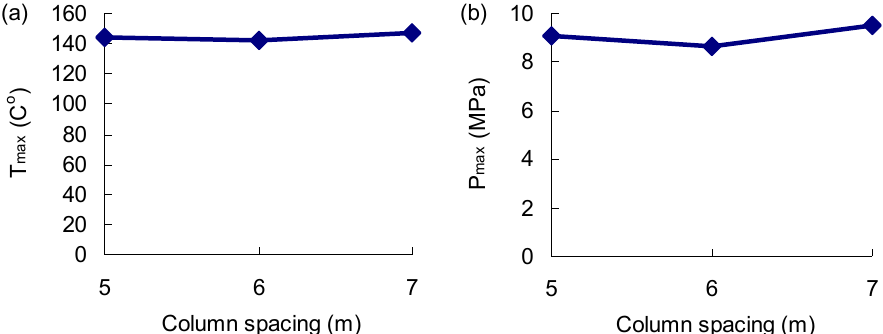
Figure 3. Maximum storage ( a ) temperature and ( b ) pressure vs. column spacing.